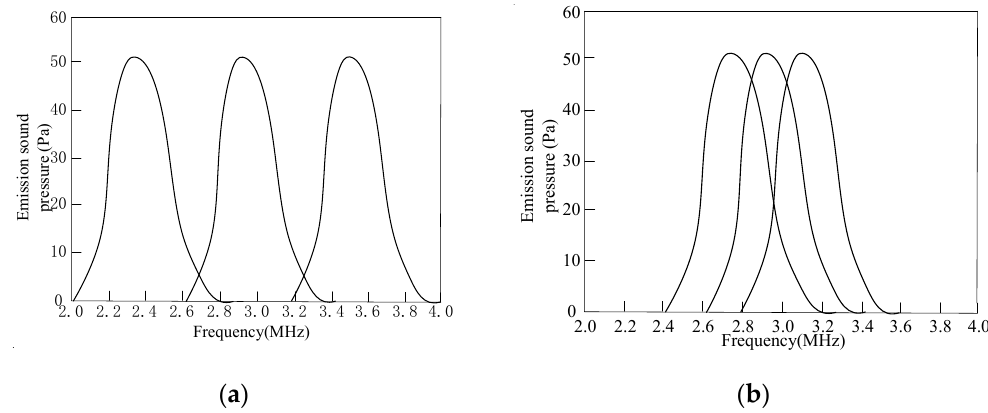
Figure 5. CMUT’s sound pressure bandwidth. ( a ) The frequency range does not overlap, ( b ) Fre- quency ranges overlap.